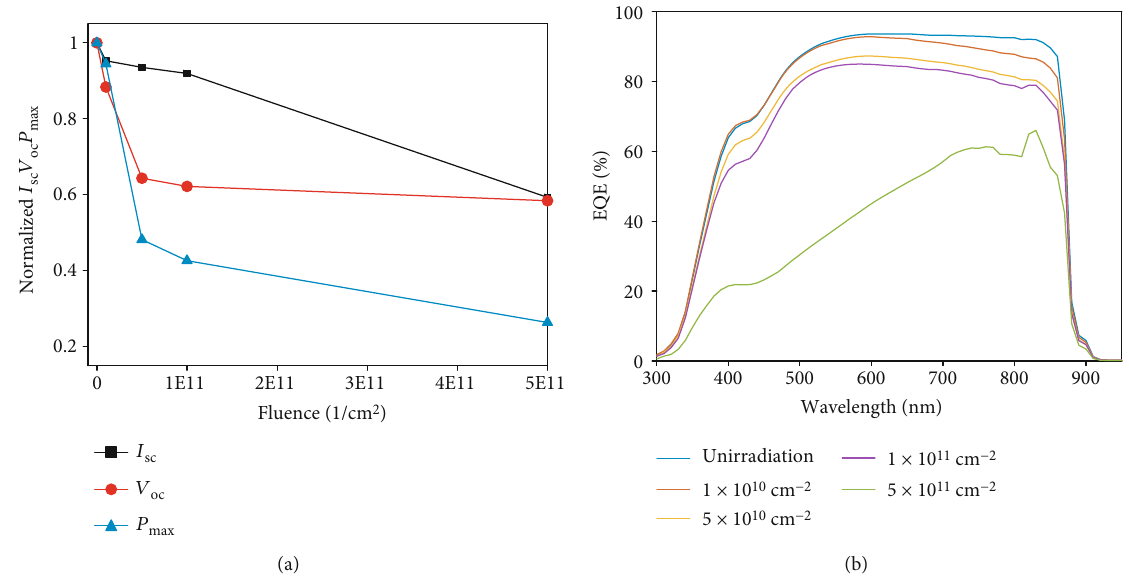
, V , and P ; SC OC max